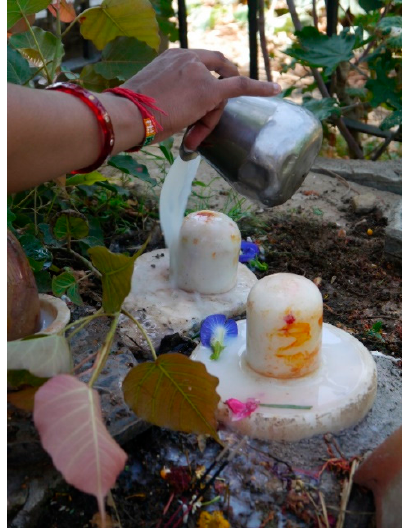
Figure 13. Woman’s worship of linga-yoni, Udaipur 2013 (picture by author).